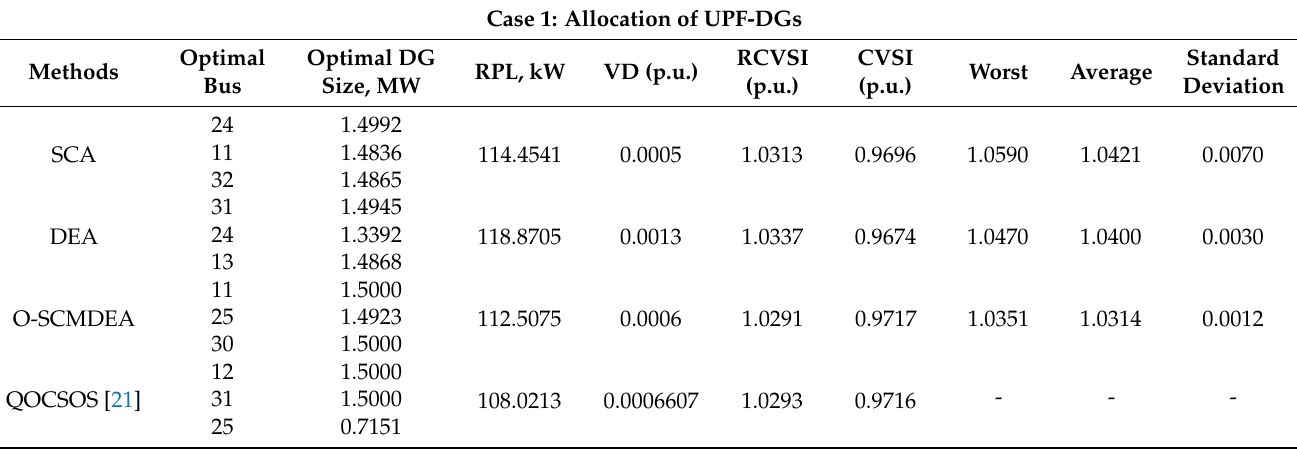
Table 6. Comparison of the results for RCVSI minimization of 33 bus DN. Case 1: Allocation of